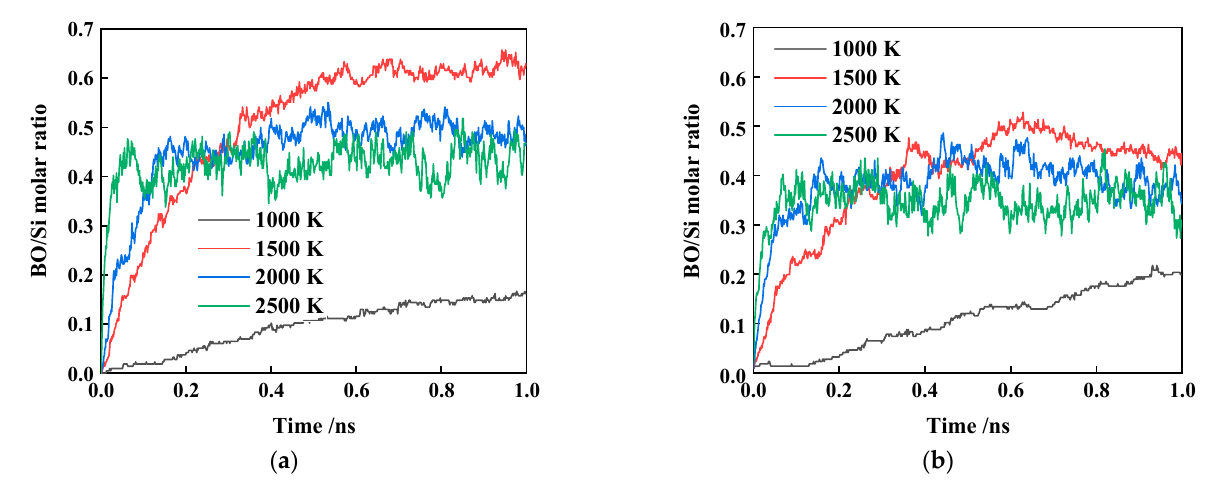
The polymerization process from the fracture of the Si-O-H bond to the formation of